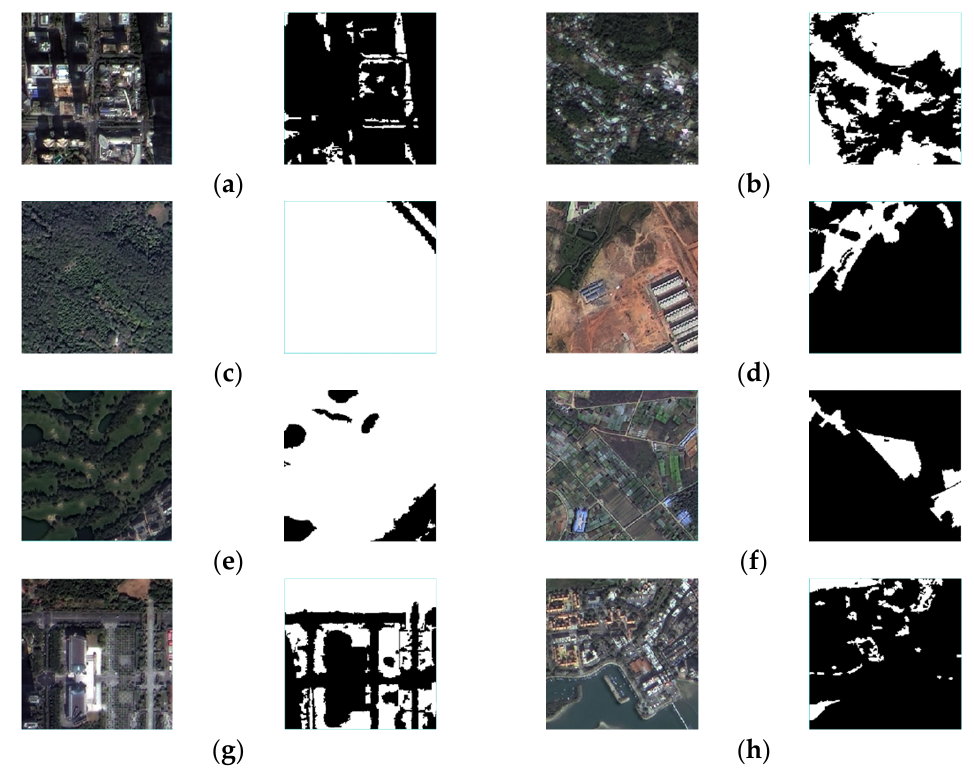
Figure 3. For samples of different green space types, the left side of each group is the original image and the right side is the label image. ( a ) High density building area; ( b ) countryside; ( c ) Suburban Forest; ( d ) Bare land; ( e ) Golf Course; ( f ) Farmland; ( g ) Land for parks and squares; ( h ) Port.